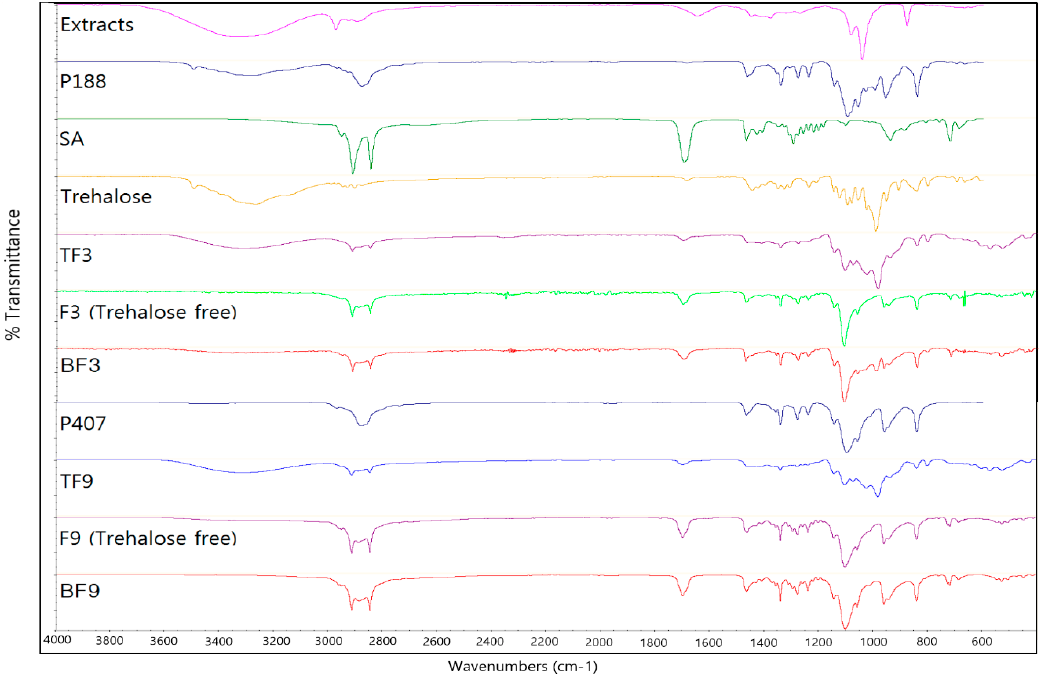
Figure 4. FT-IR spectra of H. cordata extracts, stearic acid (SA), poloxamer 188 (P188), poloxamer 407 (P407), trehalose, blank F3 (BF3), F3 (trehalose free), trehalose added F3 (TF3), blank F9 (BF9), F9 (trehalose free) and trehalose added F9 (TF9).